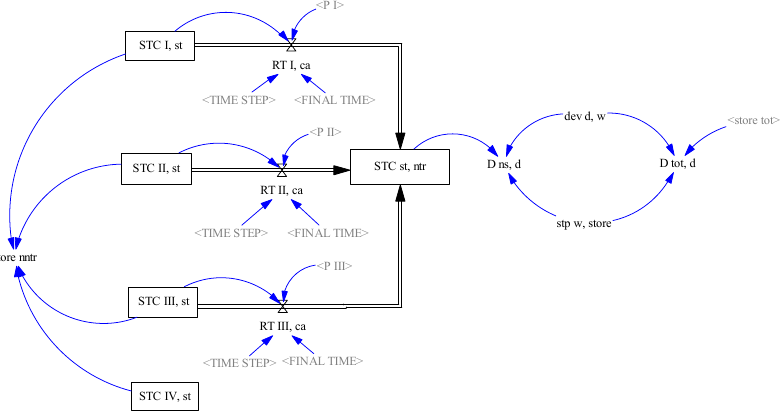
Figure 4. Graphical representation of the store stock-and-flow model in the system dynamics (SD) modeling software VENSIM.